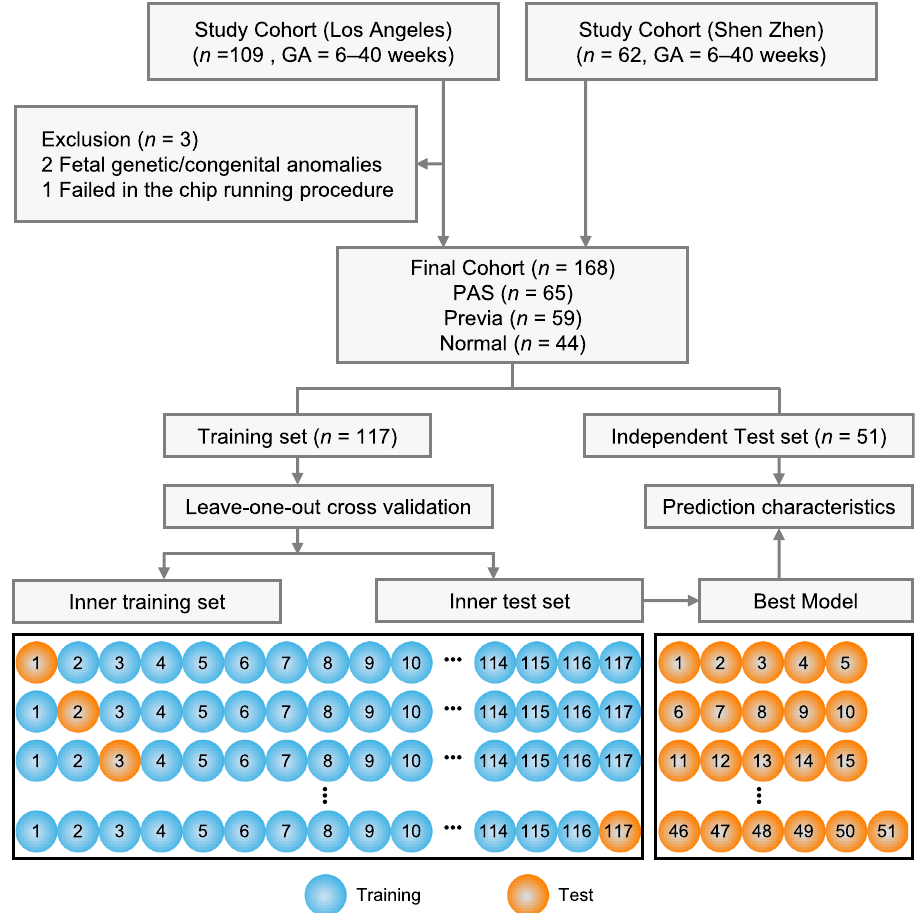
Fig. 3 Clinical study design fl owchart depicting the recruitment and exclusions from the study cohort. Blood samples from 109 and 62 eligible study subjects gestational age (GA, 6 – 40 weeks) were collected and processed in Los Angeles, USA, and Shenzhen, China, respectively. After 3 samples were excluded due to fetal genetic/congenital anomalies or technical failure, blood samples from a fi nal cohort of 168 pregnant women were subjected to NanoVelcro Chip assay and analyzed according to the combination of single and clustered cTBs, as well as